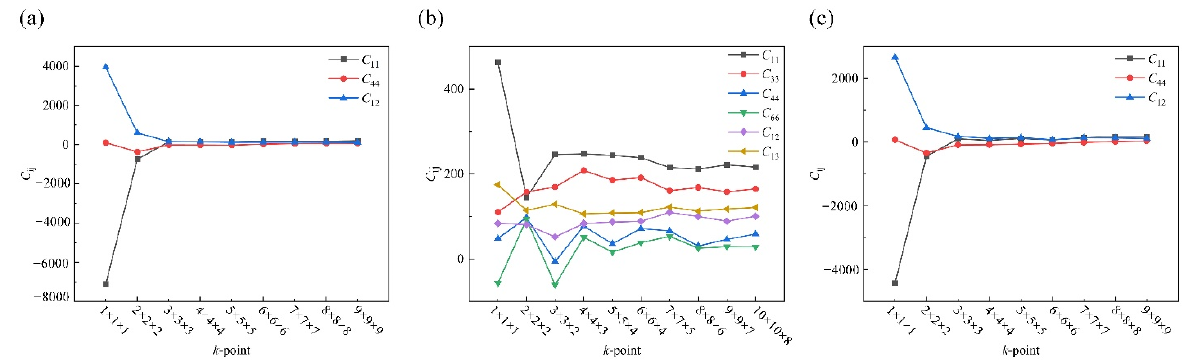
3 , ( b ) AuCu, ( c ) Au 3 Cu.